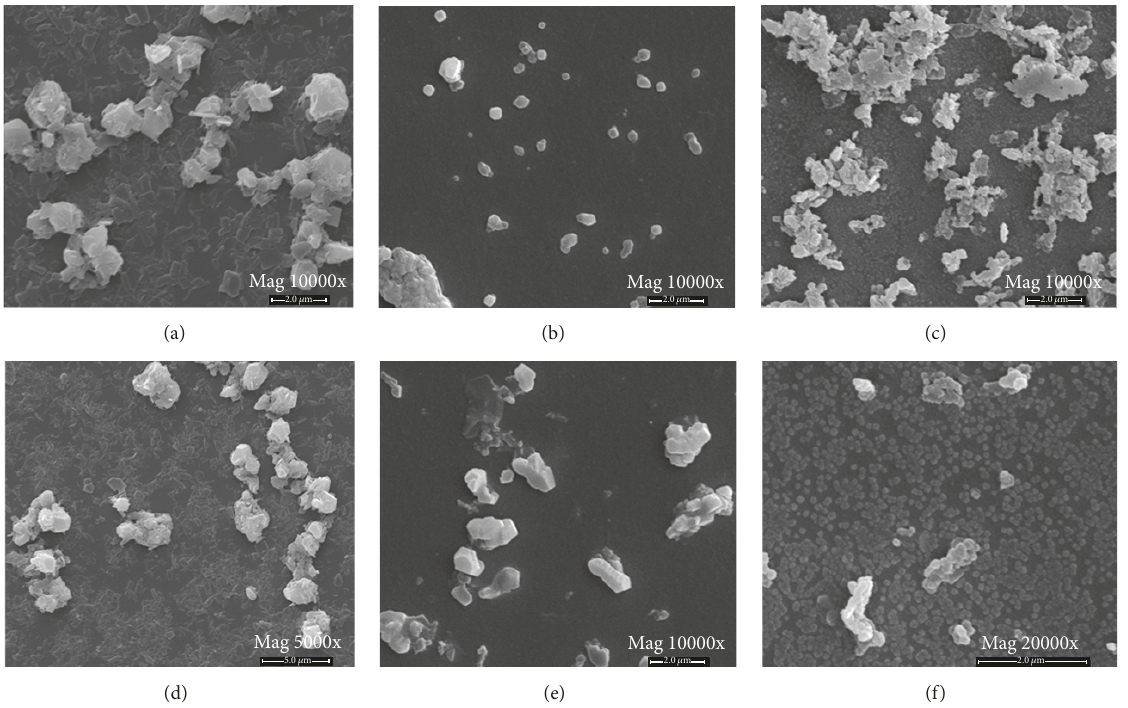
Figure 6: SEM images of HCPTNPs using SDS as surfactants under different HP and amount conditions: (a) 0.5 mg, 600 bar; (b) 0.5 mg, 800 bar; (c) 0.5 mg, 1000bar; (d) 2.5 mg, 600 bar; (e) 2.5 mg, 800 bar; (f) 2.5 mg, 1000bar.